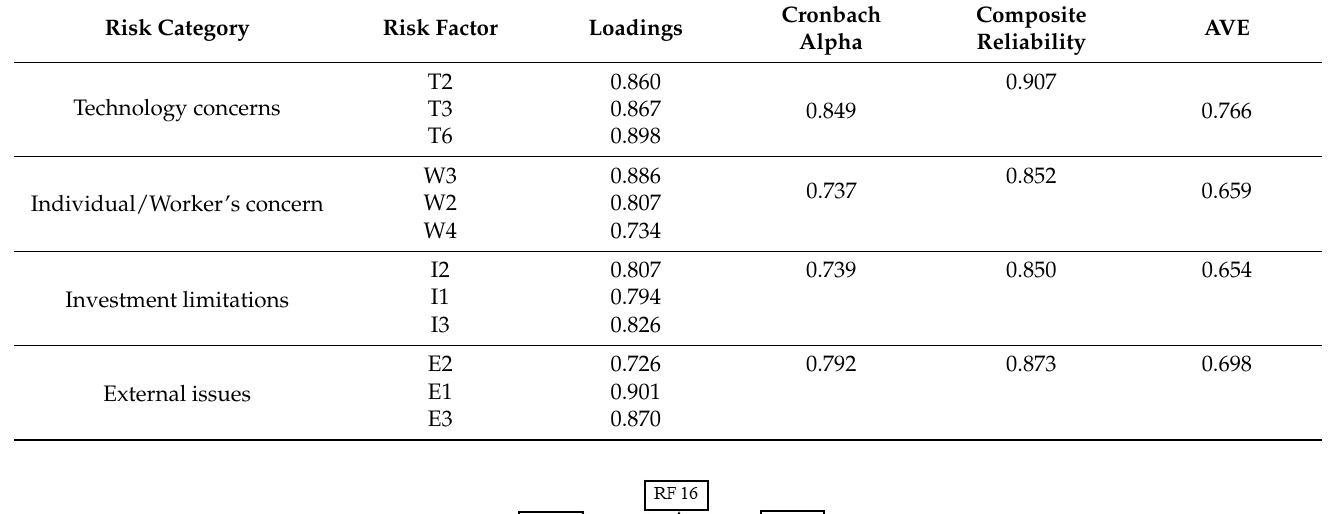
Table 5. Measurement model evaluation.